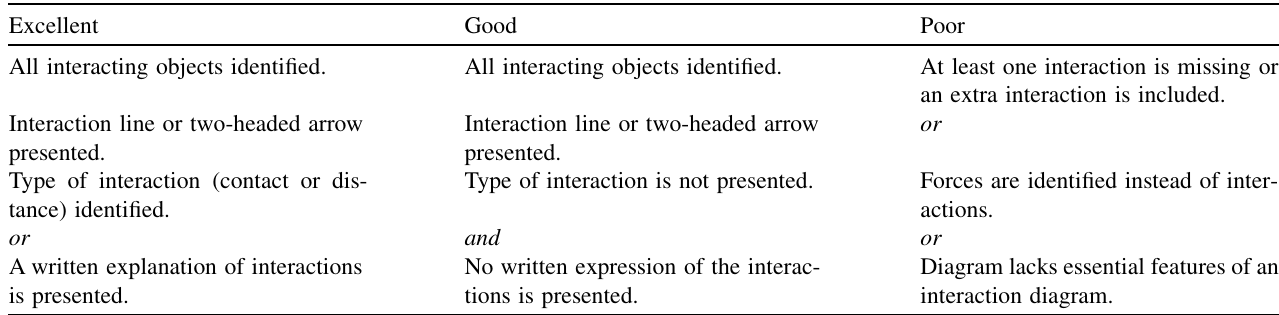
TABLE III. The classification of the quality of students’ interaction diagrams.